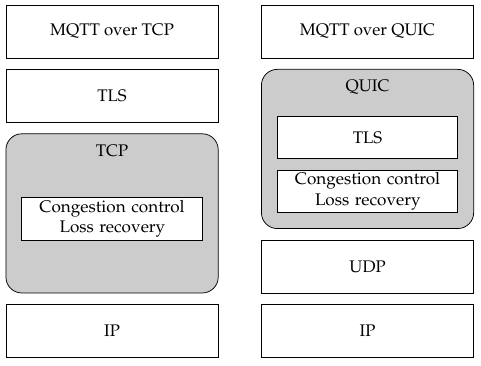
Figure 2. MQTT over TCP and